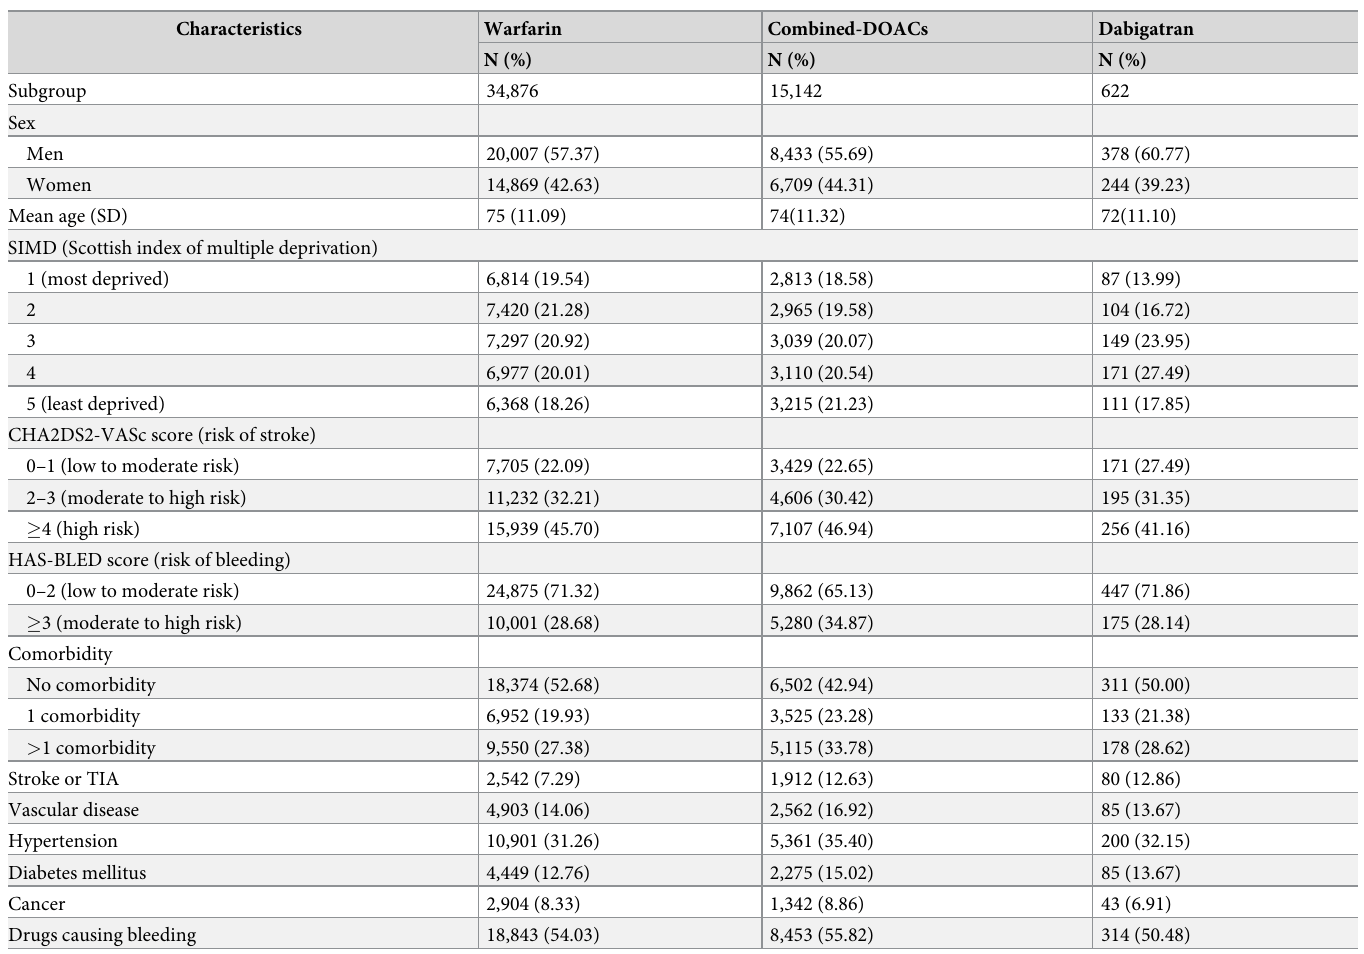
Table 1. Baseline characteristics.